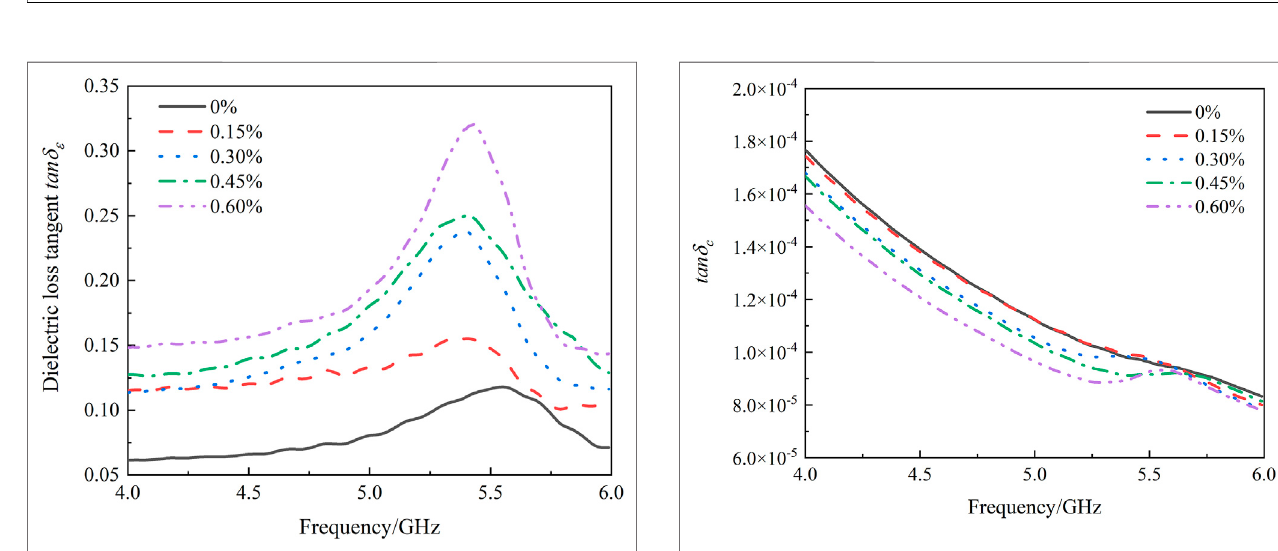
FIGURE 4 | Dielectric constant curve with frequency. (A) Real part of dielectric constant (B) Imaginary part of dielectric constant.